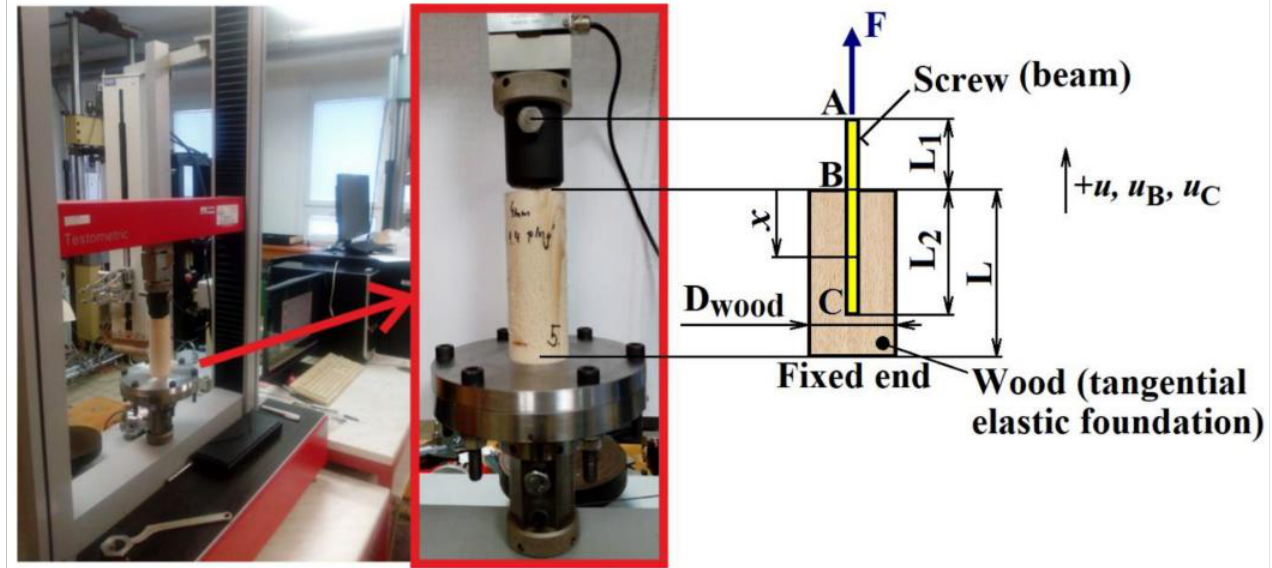
10%) purchased at a supermarket was